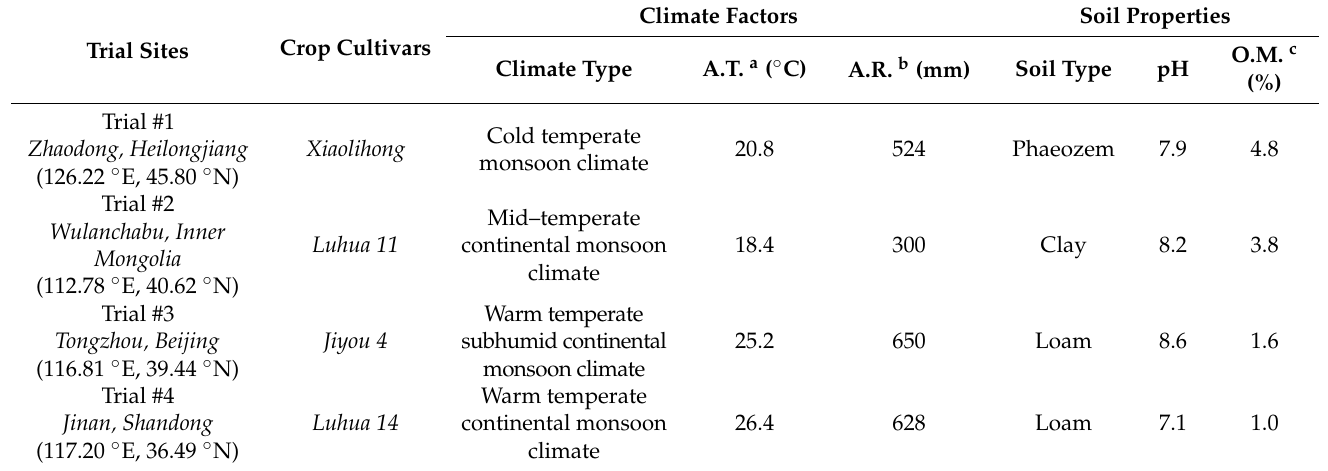
Table 3. Crop cultivars, climate characteristics and soil physicochemical properties of trial sites in the